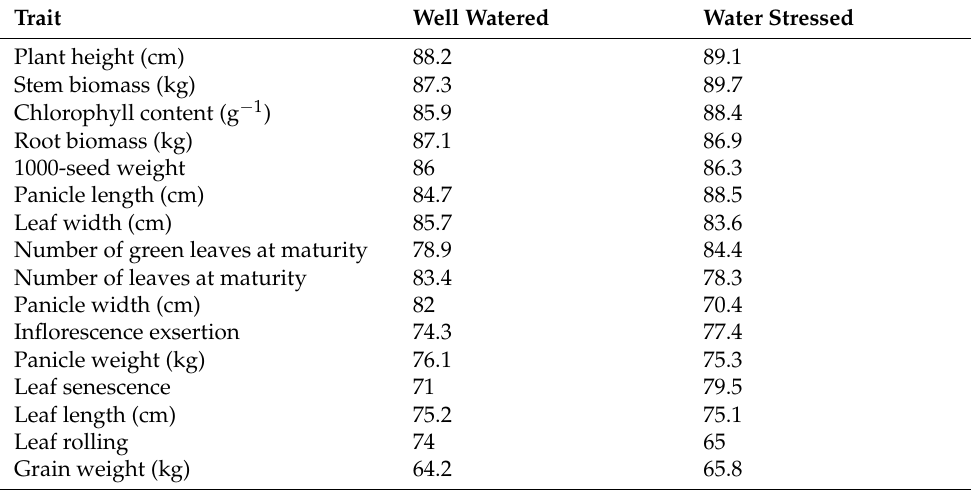
Table 9. Broad-sense heritability (%) of parents and backcrosses.